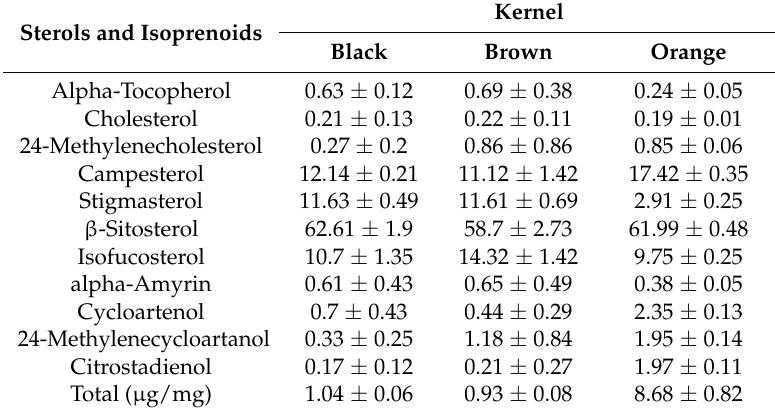
Table 3. Phytosterol and Isoprenoid Composition of Arachis hypogaea Seed Kernels of Different Classes.